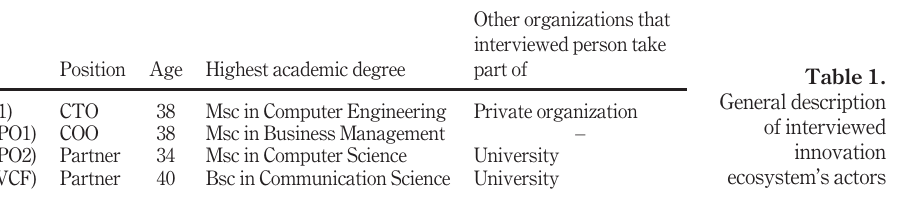
Table 1. General